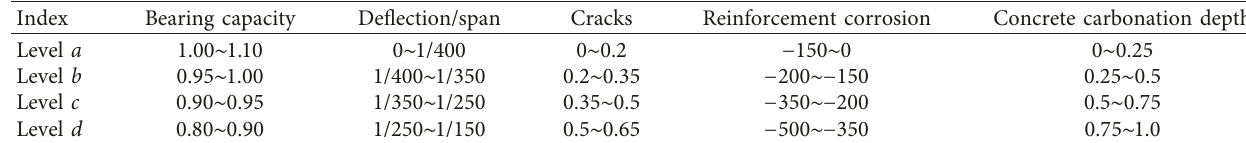
Table 3: Safety grades and corresponding ranges of the five indices.